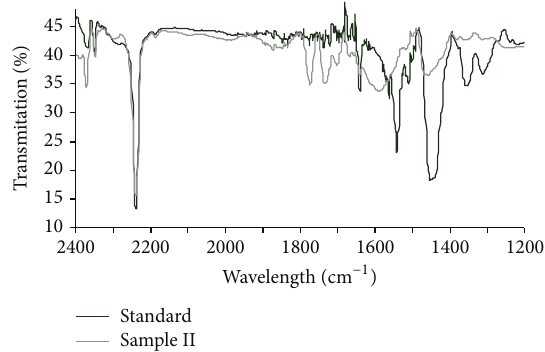
Figure 1: FTIR spectra of the NBR rubber vulcanizates without (standard) and with keratin blended with ZnO (sample